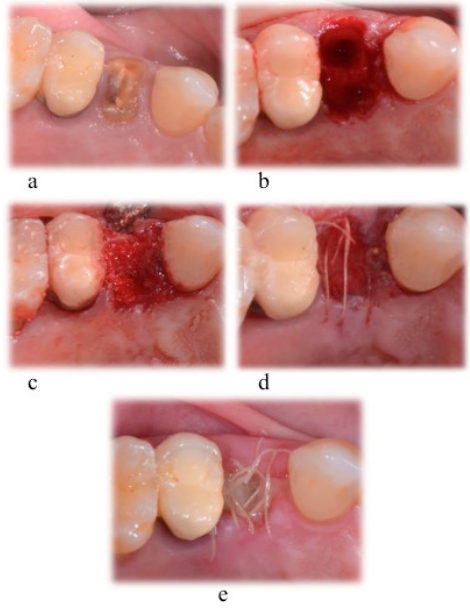
Figure 1. Tooth extraction and socket preservation. Surgical phases for: ( a ) Local anesthesia; ( b ) extraction socket; ( c ) socket filled with biomaterial; ( d ) suture with 4–0 vycril suture; ( e ) 1 week healing.